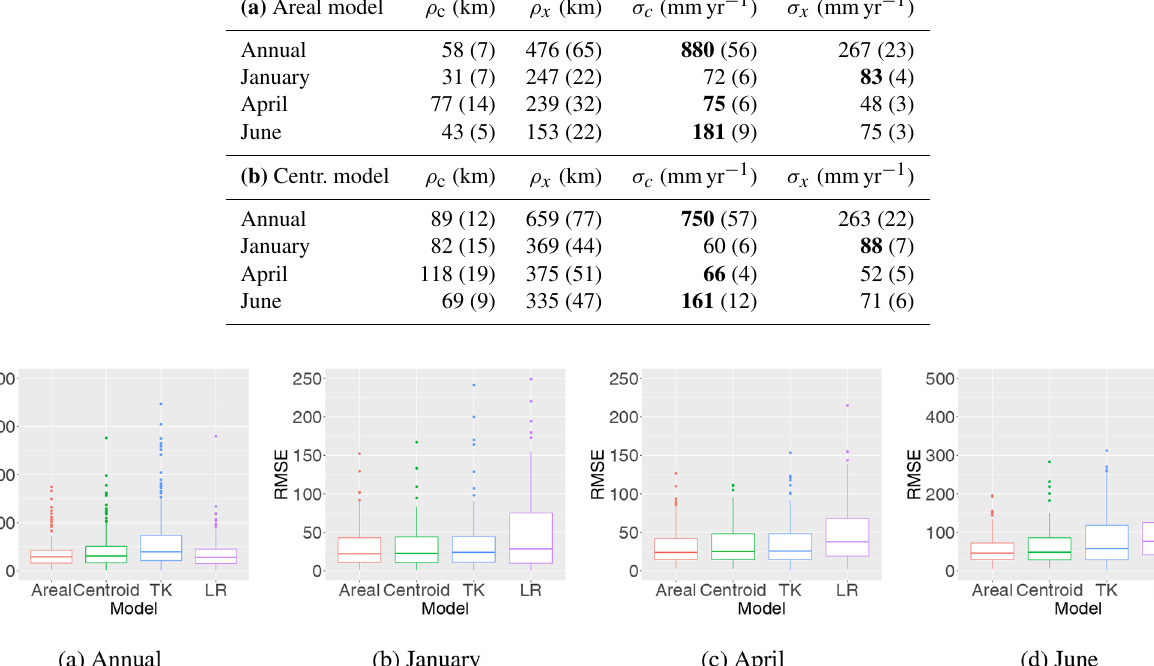
Figure 9. Distribution of RMSE (mmyr − 1 and mmmonth − 1 ) for infill of missing values for all catchments and years (1996–2005) for the areal model, centroid model and top-kriging when the target catchments are treated as partially gauged (PG); i.e. a short record of length 1 from the target catchment is included in the observation likelihood in the cross-validation. Results for linear regression (LR) are also included